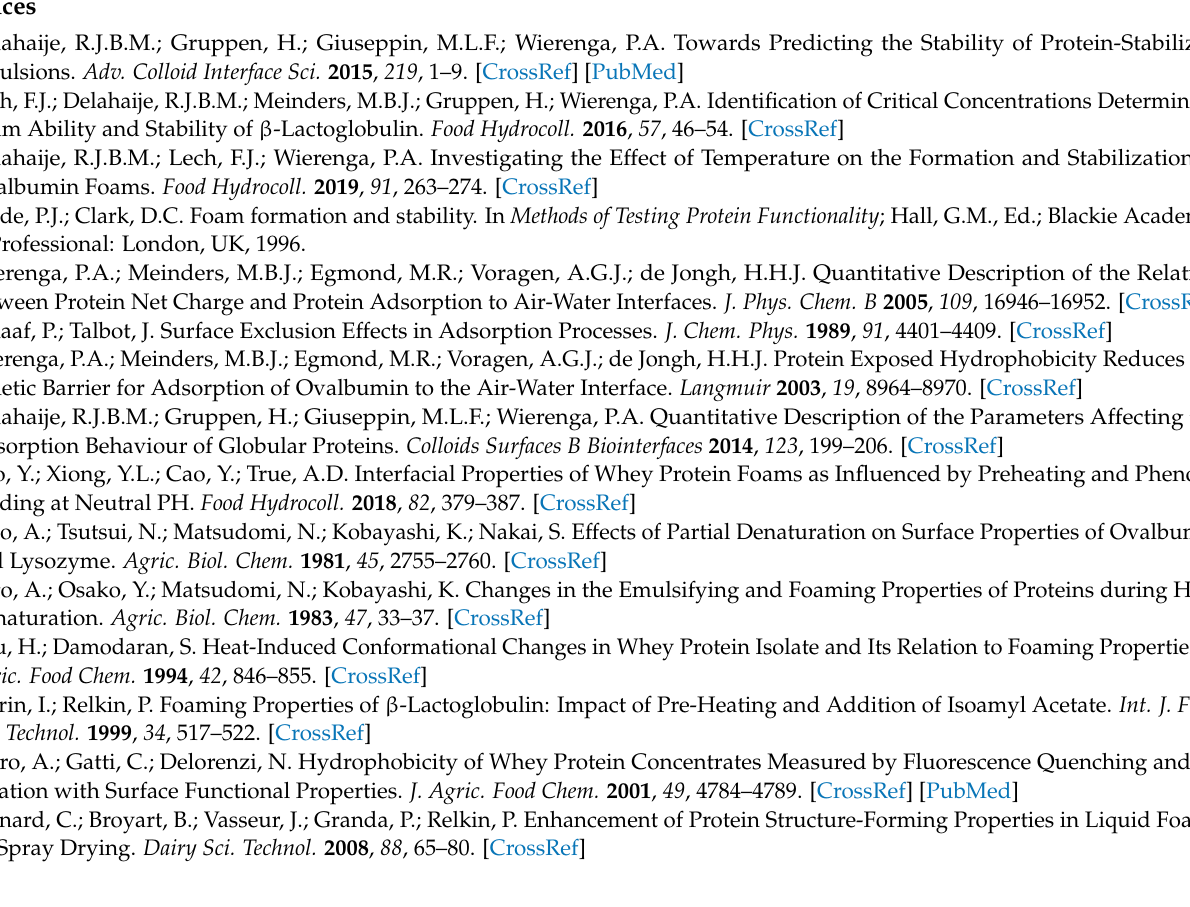
Figure 2. Effect of heating at 77 °C on the number of charges per lysozyme molecule as a function of pH ( A ), the relative exposed hydrophobicity (Q H ) as function of heating time ( B ), and the turbid- ity ( C ) and solubility ( D ) as function of pH for (un-)heated lysozyme; 0 – 120 min ( ), 0 ( ), 15 ( ), 30 ( ), 60 ( ), 90 ( ), and 120 min ( — 10 mM sodium phosphate buffer pH 5.7). The error bars in panel A indicate the standard deviation. The solid lines in panel B – D are guides to the eye. The insert in panel D shows the data with rescaled y -axis.